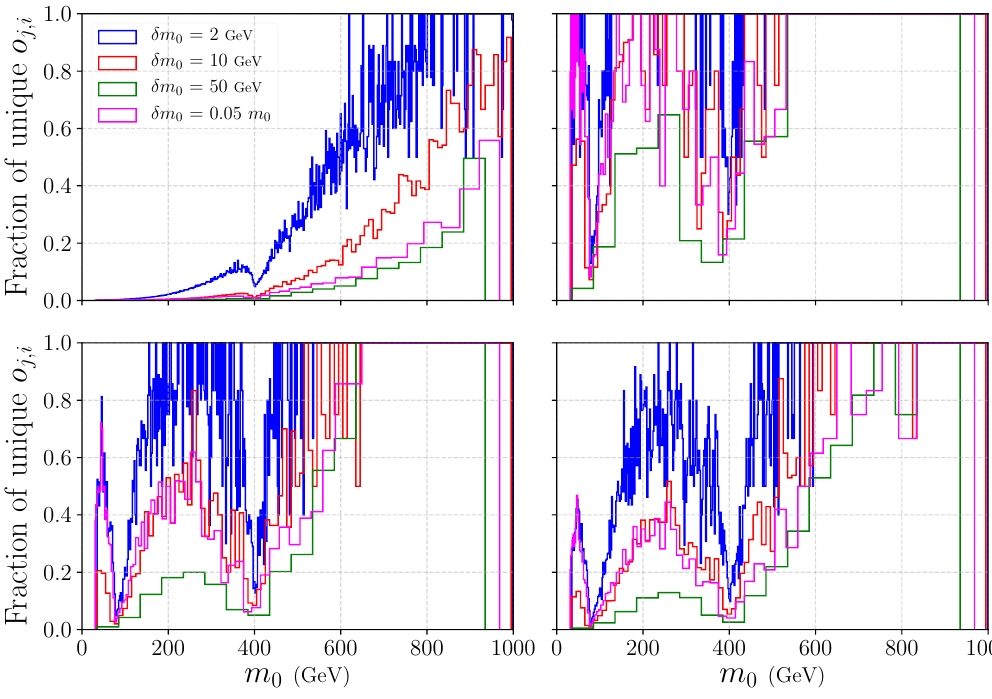
Figure 12 . Fraction of unique measurements in W 0 event samples, using the mass basis observables ( m 0 , m 1 =m 0 ) for di(cid:11)erent choices of m 0 binning. From top-left to bottom-right: results for a mixed sample of 9 10 4 events with S = B = 5% and four di(cid:11)erent choices of bin sizes, followed by results (cid:2) for 100, 500 and 1000 pure signal events at various bins sizes of (cid:14)m 0 = 2 GeV, 10 GeV 50 GeV, and 0 : 05 m 0 (cid:2)